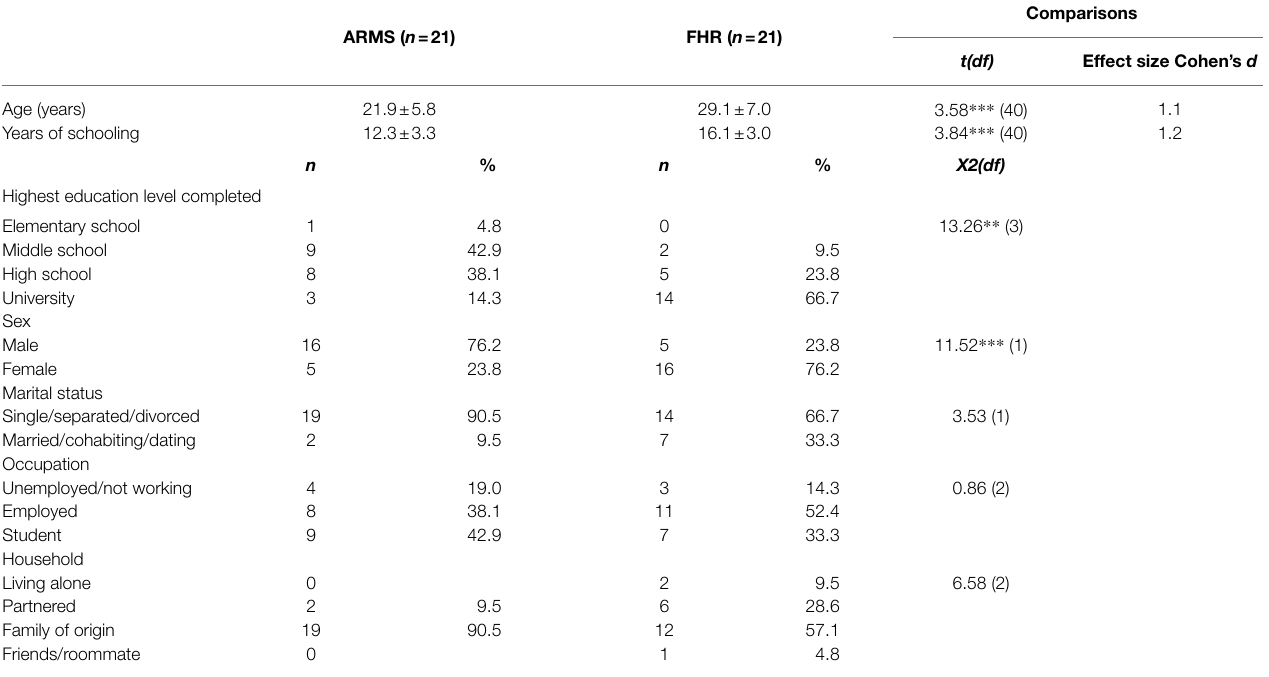
TABLE 1 | Demographic characteristics of sample ( N =